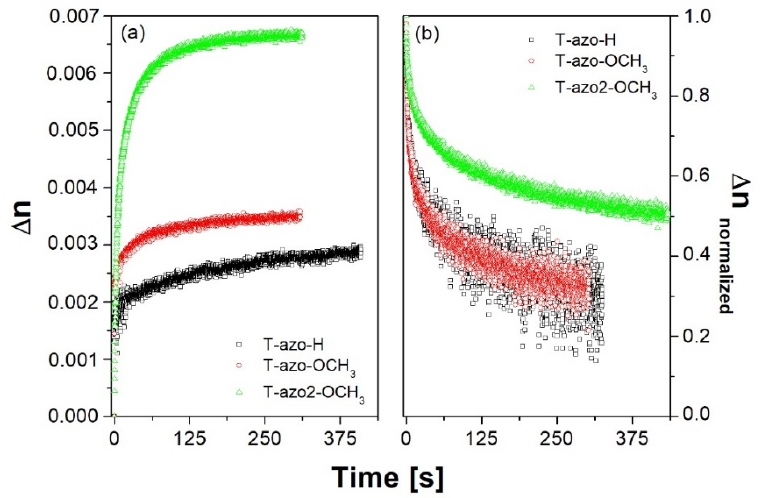
Figure 4. Birefringence ( a ) growth and ( b ) normalized relaxation curves for the thiazole–azo dyes dispersed in PMMA matrix thin films ( λ exc. = 445 nm, λ probe = 690 nm).